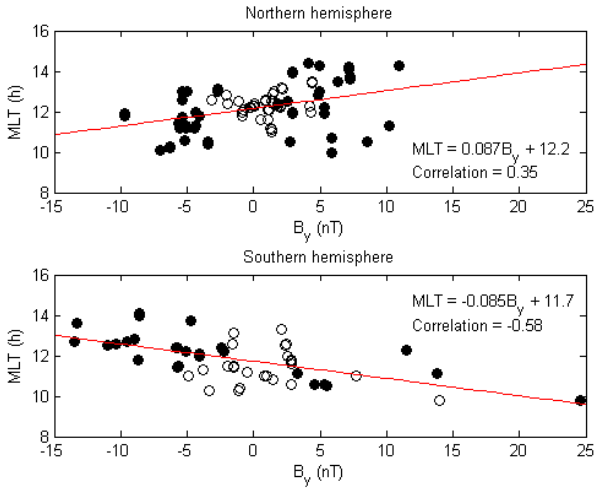
Fig. 15. Location of the cusp poleward (top) and equatorward (bottom) boundaries for steady and positive B z dominated IMF ( | θ IMF | < 45 ◦ ) as a function of the solar wind dynamic